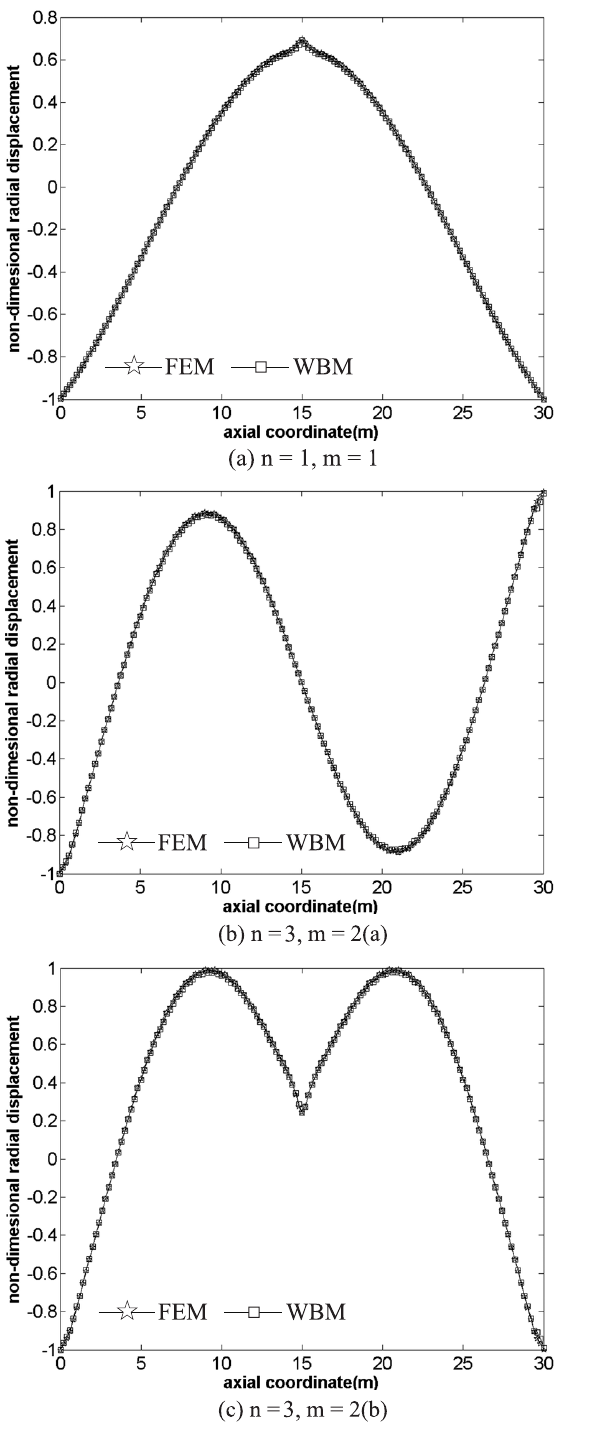
Fig. 10. Comparison of vibration mode shapes of model M2 calcu- lated by FEM and WBM for C-C boundary